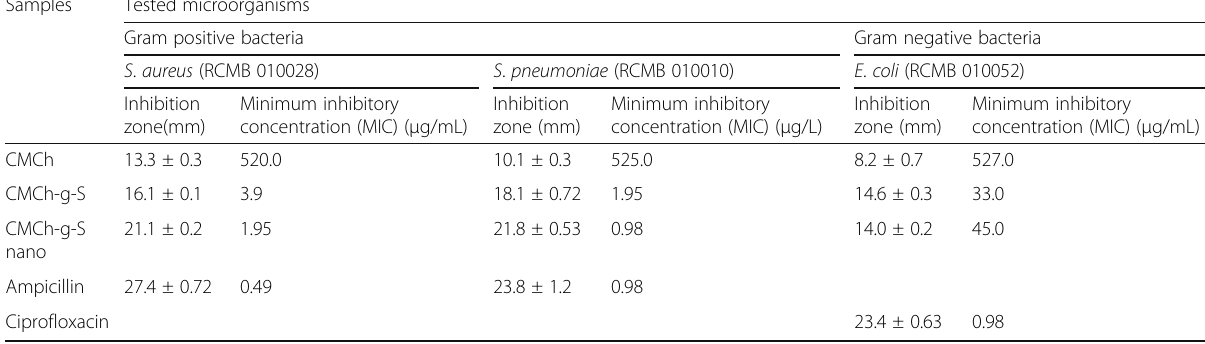
Table 1 Antibacterial activity of CMCh, CMCh-g-S and CMCh-g-S nano